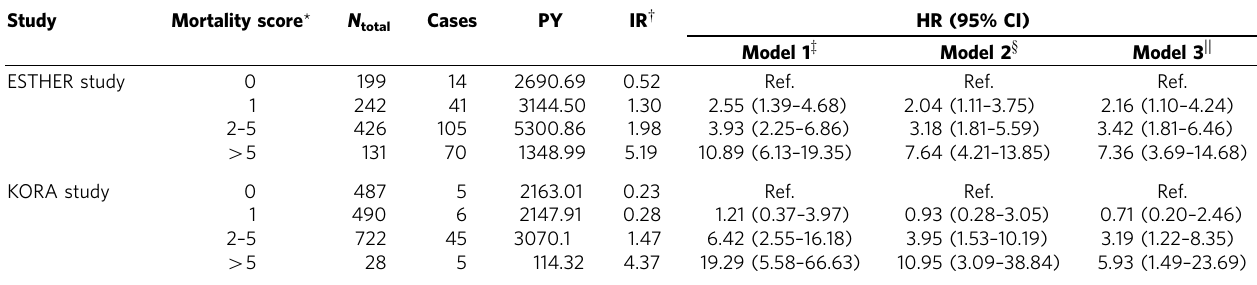
Table 3 | Association of the risk score with all-cause mortality in the ESTHER and KORA study.